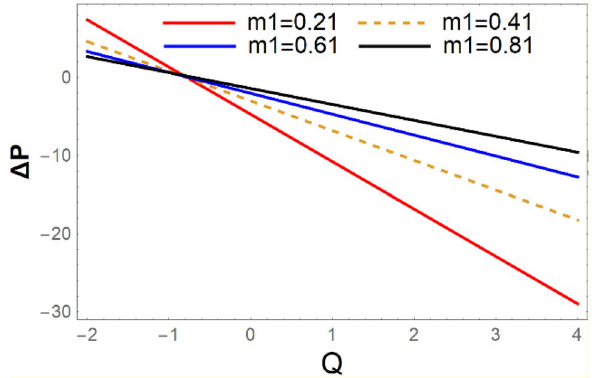
Figure 4. (cid:31) p impact for varying m1.